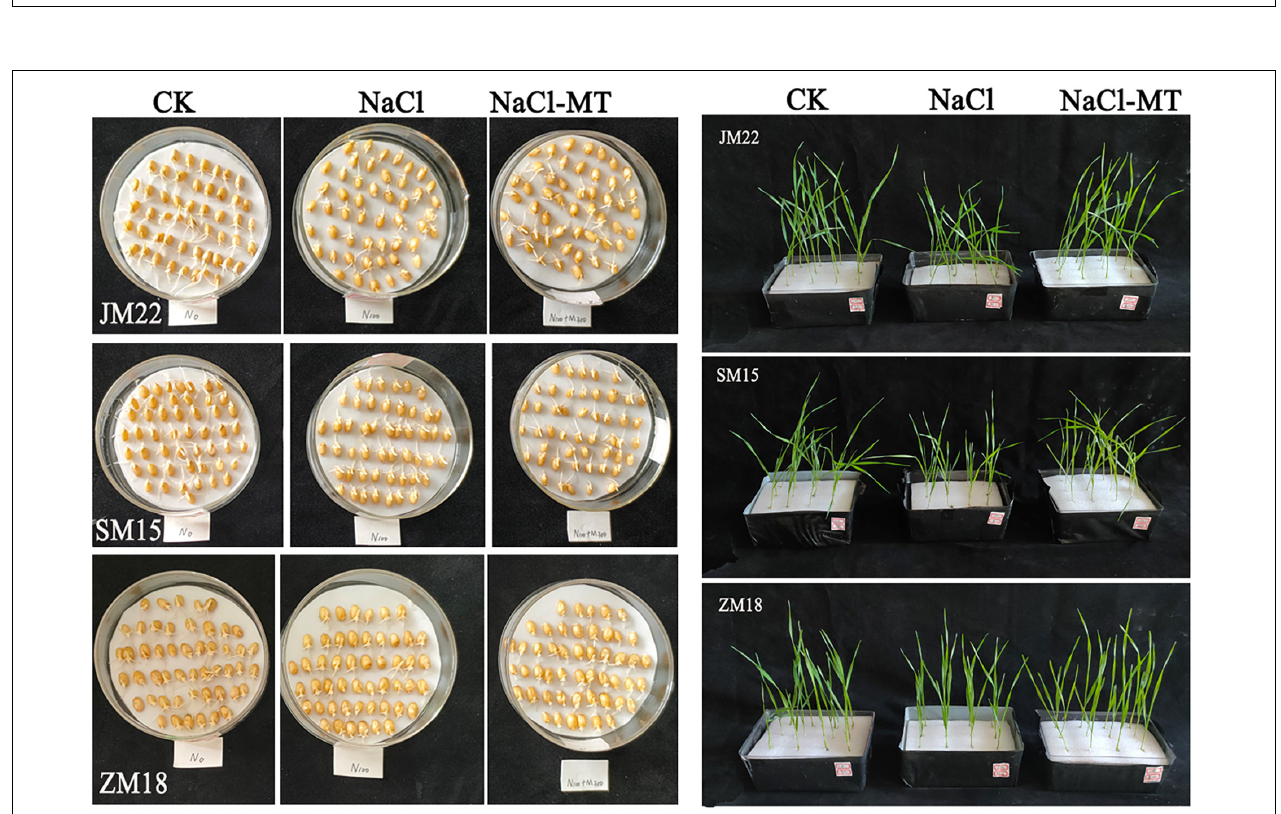
FIGURE 9 | Schematic diagram of seed germination and seedling growth with MT under salt stress.